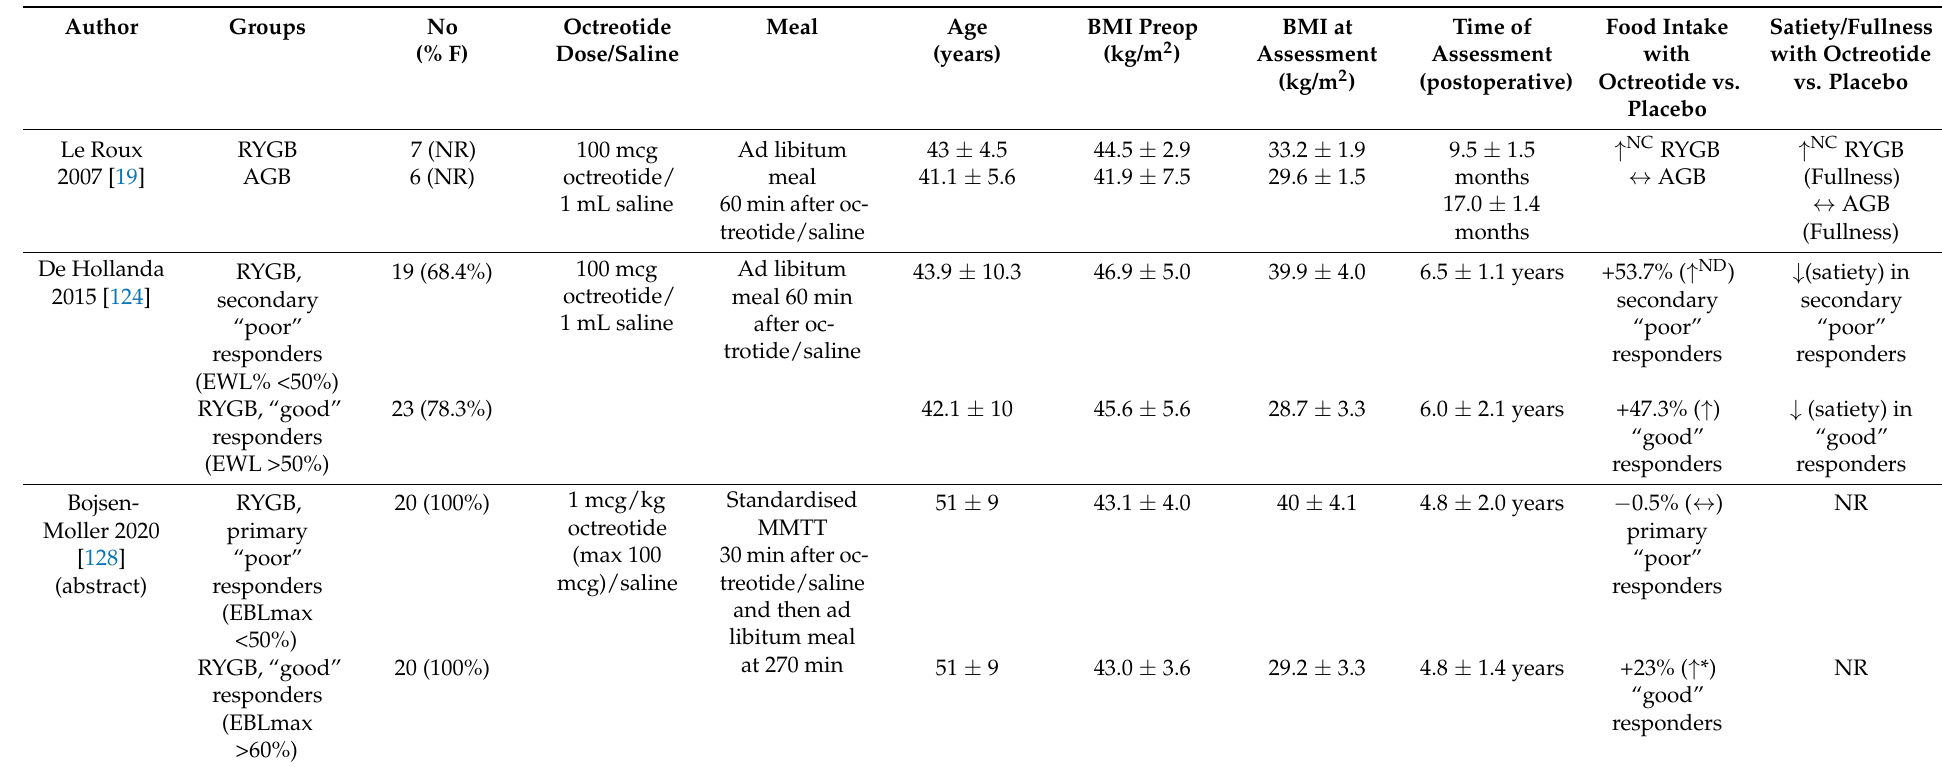
Table 2. Studies using octreotide to assess food intake and satiety after bariatric